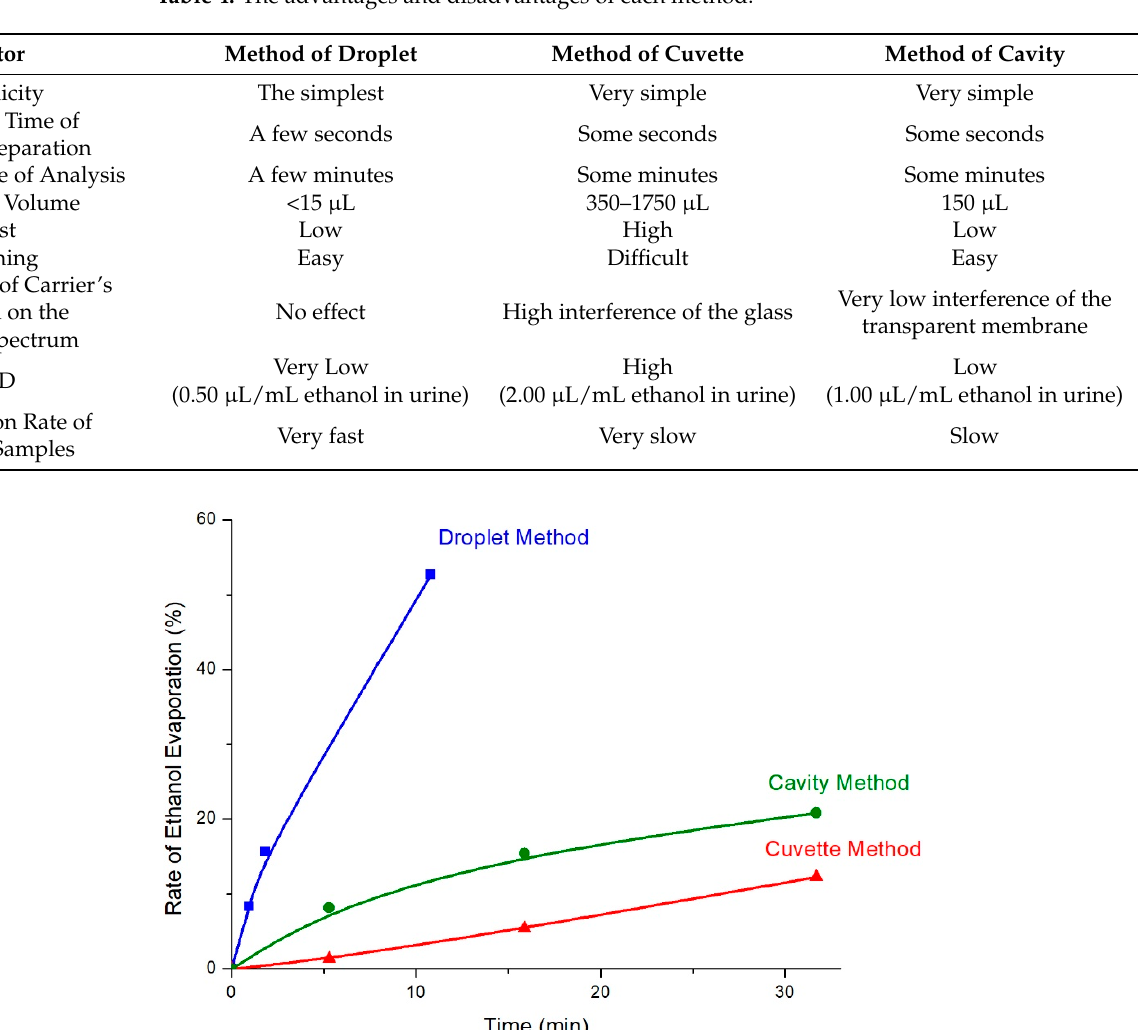
Table 4. The advantages and disadvantages of each method.